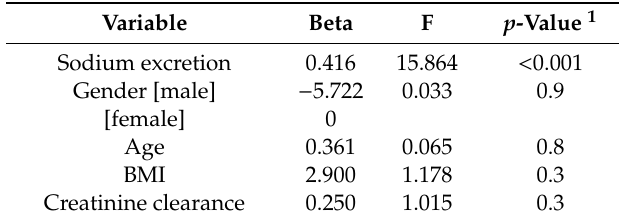
Table 2. Determinants of iodine